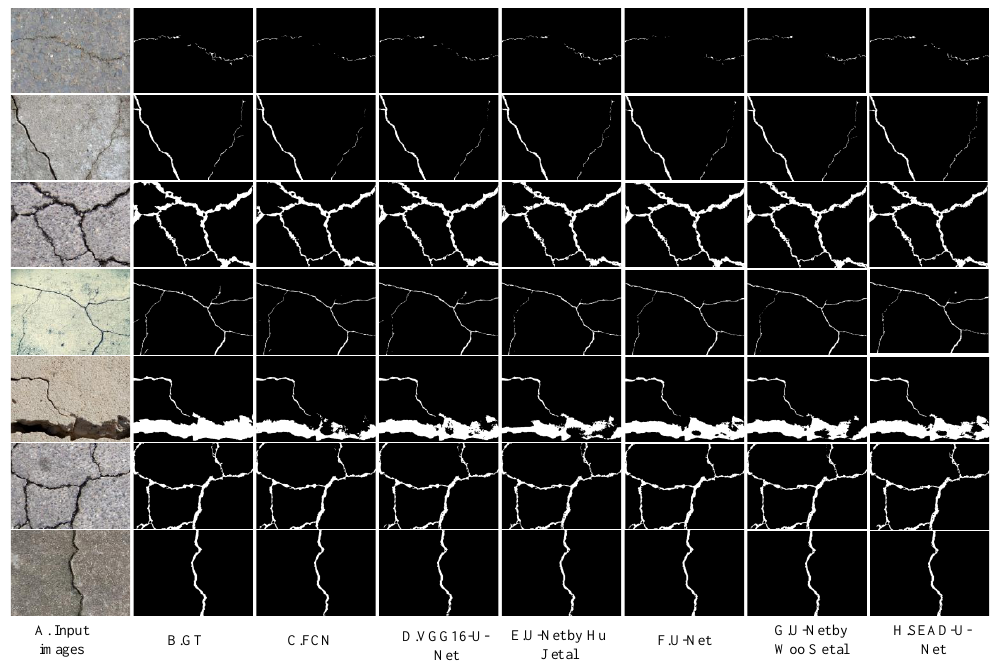
Figure 9. DeepCrack dataset segmentation result